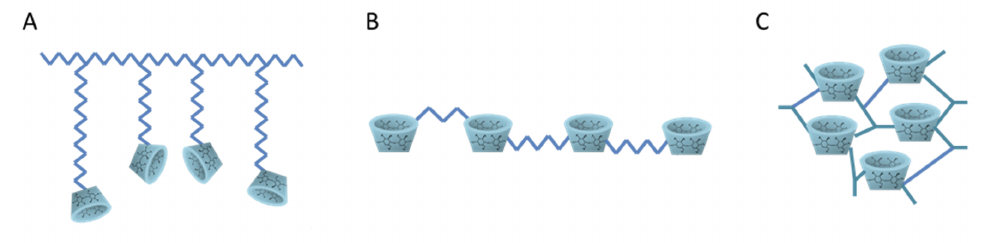
Figure 3. Types of polymers containing cyclodextrins: ( A ) pendent, ( B ) linear, and ( C )